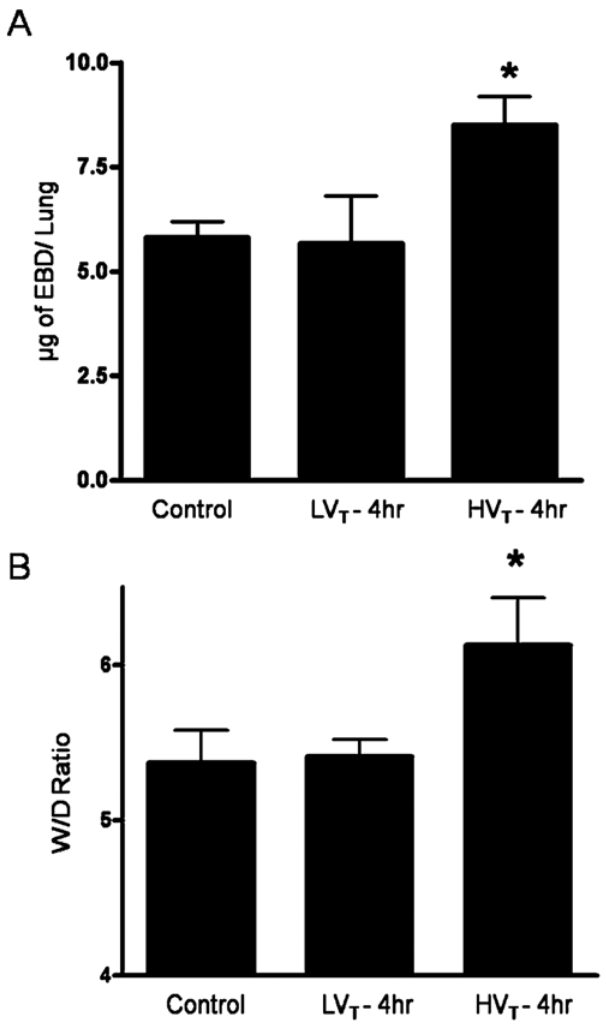
Figure 1. High tidal volume mechanical ventilation causes lung injury. C57BL/6J mice were randomized to spontaneous breathing (Control), LV T (7 ml/kg), and HV T (20 ml/kg) MV for 4 hours and EBD extravasation and wet-to-dry lung weight ratios were assessed A. The amount of EBD extravasation after MV at HV T was significantly higher compared to MV at LV T or spontaneous breathing (8.51 m g 6 0.68, 5.67 m g 6 1.12 and 5.82 m g 6 0.37 respectively), B. The wet-to-dry lung weight ratio was significantly higher after MV at HV T compared to MV at LV T or spontaneous breathing (6.13 6 0.30, 5.41 6 0.10 and 5.37 6 0.21 respectively). * P , 0.05 (HV T vs all others). N=4–5 mice per